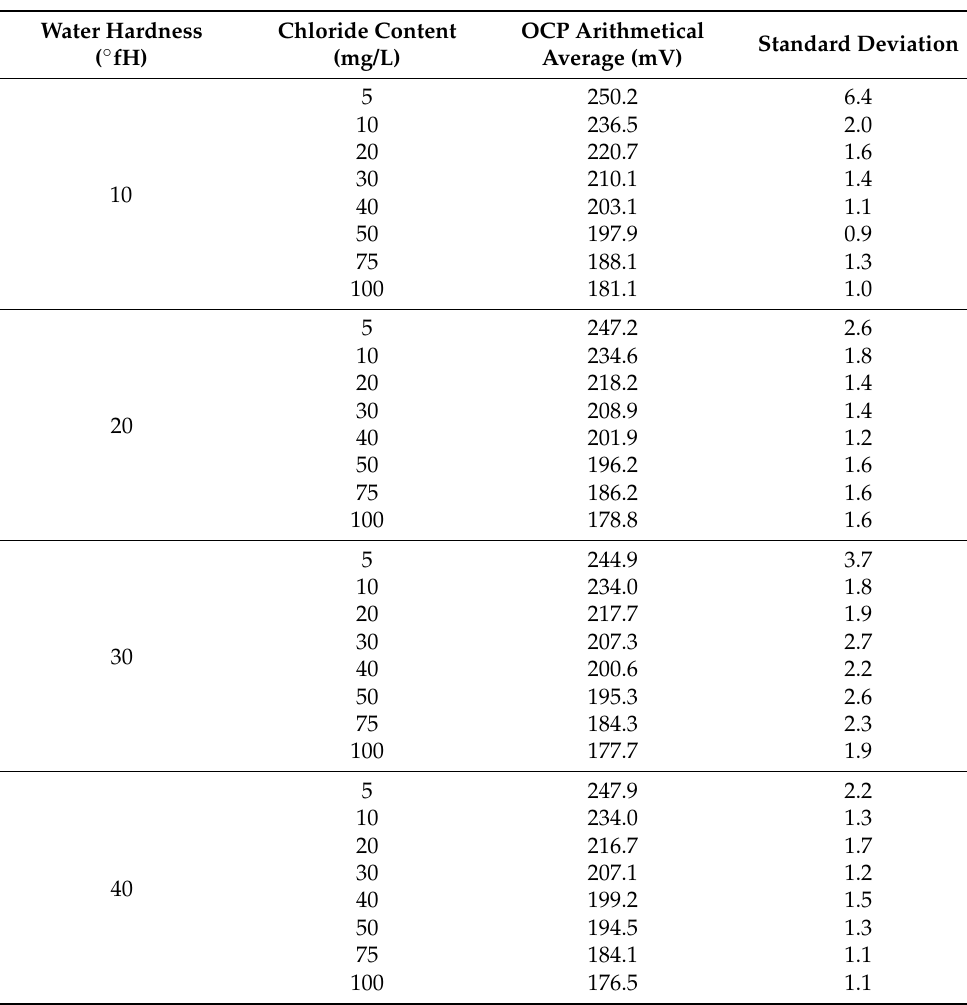
Table 2. Arithmetical average and standard deviation of the sensor’s OCP response in 10–40 ◦ fH solutions with different chloride content (5–100